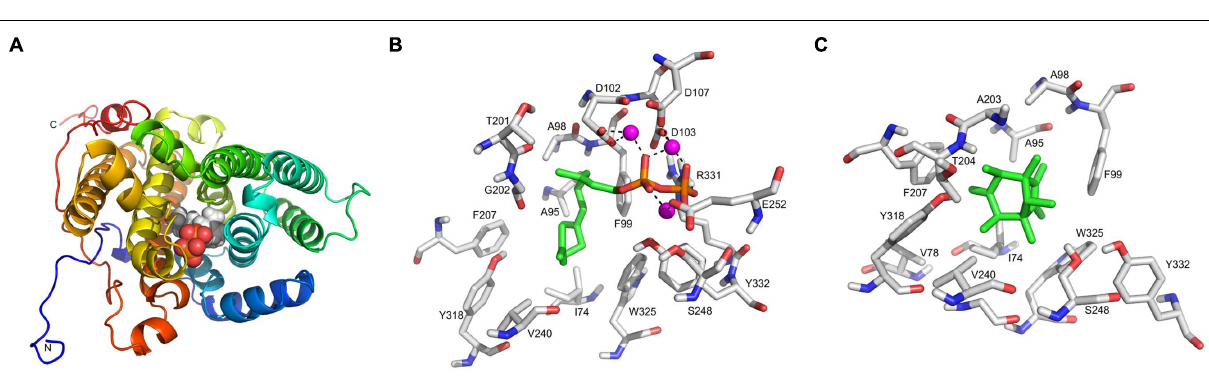
FIGURE 7 | Homology modeling of the Serratia plymuthica 4Rx13 terpene cyclase. (A) The model of the tertiary structure of S. plymuthica 4Rx13 terpene cyclase is shown in rainbow representation starting from the N-terminus in blue color to the C-terminus in red color. The position of farnesyl diphosphate in the active site is highlighted in van der Waals radii representation. (B) Model of the active site with bound farnesyl diphosphate (green carbon atoms). (C) Model of the active site with bound sodorifen (green carbon